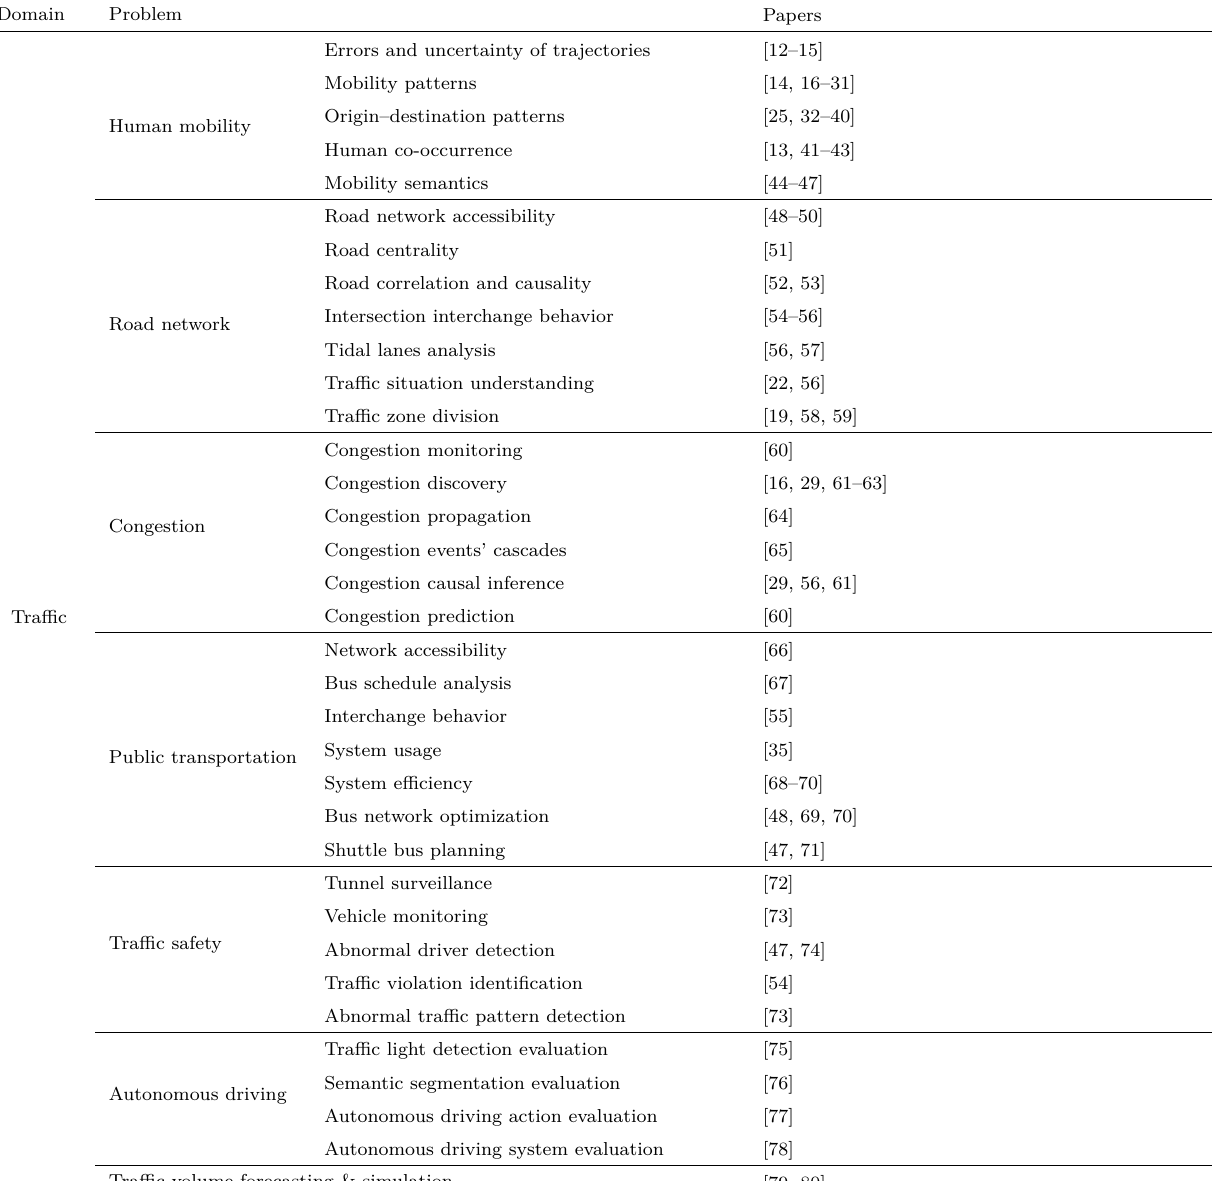
Table 1 Domain problems studied by existing urban visual analytics approaches (continued in Table